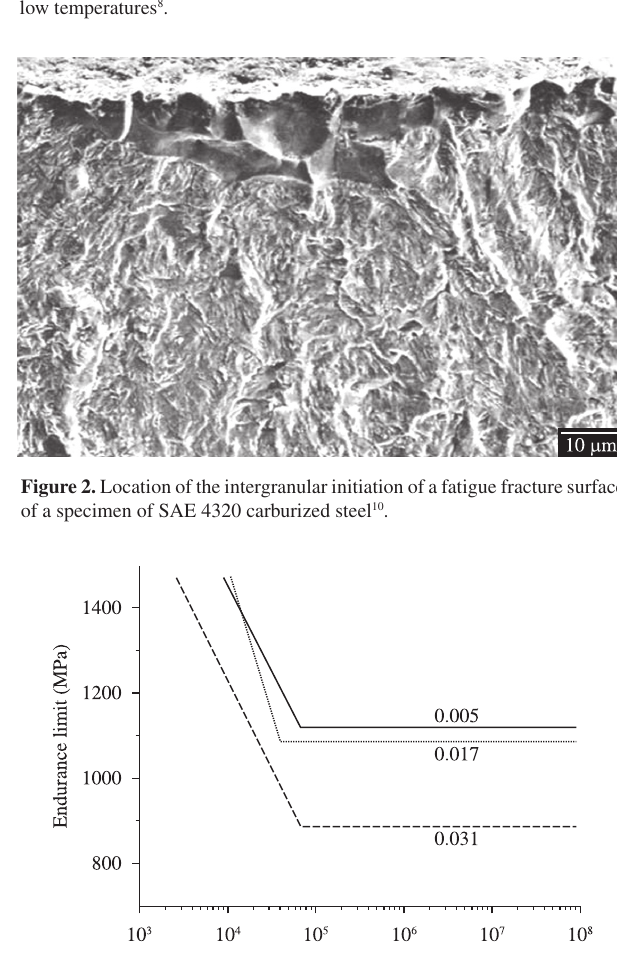
Figure 1. Fracture mode due to P and C contents for martensite tempered at low temperatures 8 .